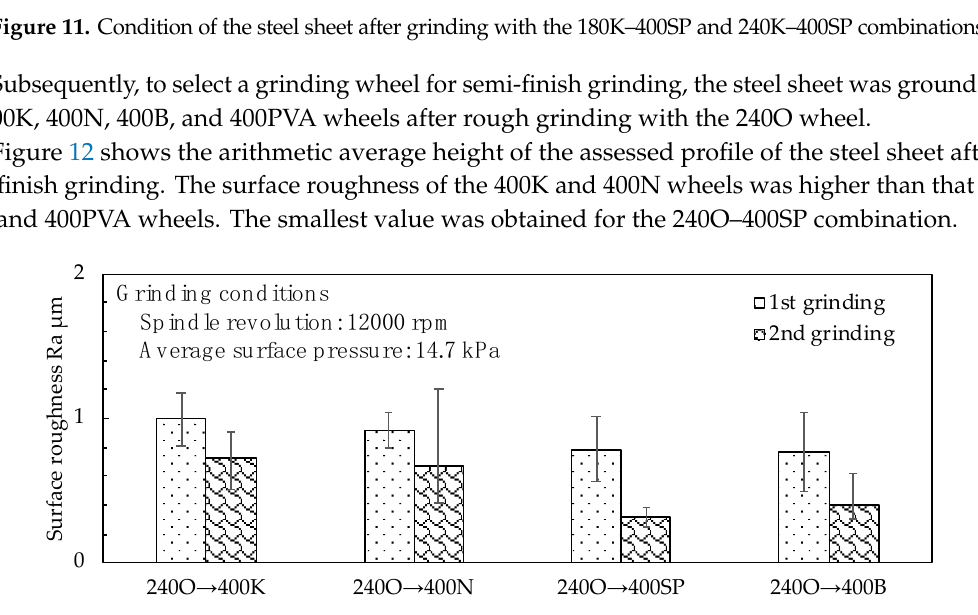
Figure 12. Arithmetic average height of the assessed profile of the steel sheet after the semi-finish grinding.